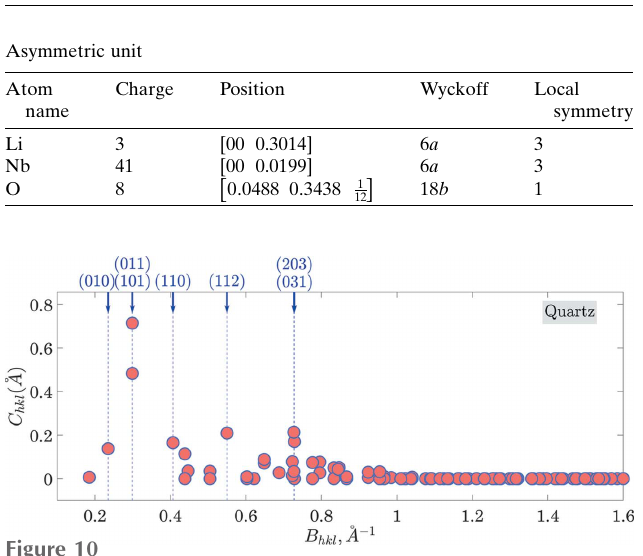
Figure 10 Same as Fig. 4 but for the case of quartz.